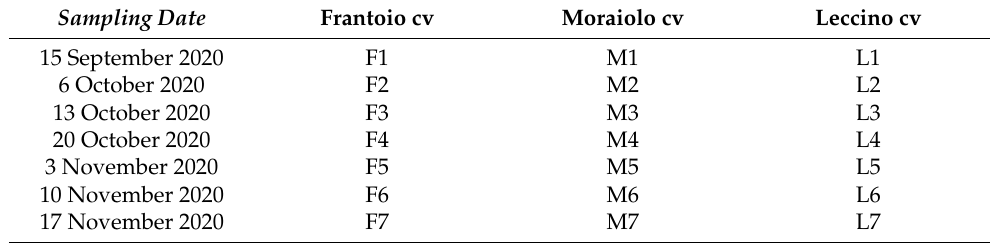
Table 4. The olive fruit samples of three Tuscan cultivars collected over the course of ripening in